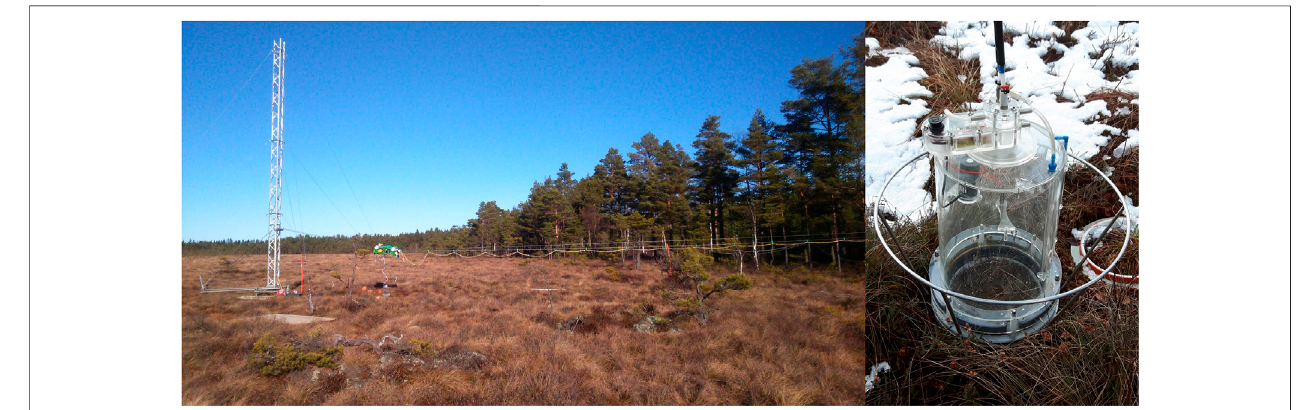
FIGURE 1 | The SkyLine2D system used for GHG measurements at the Mycklemossen fi eld site.